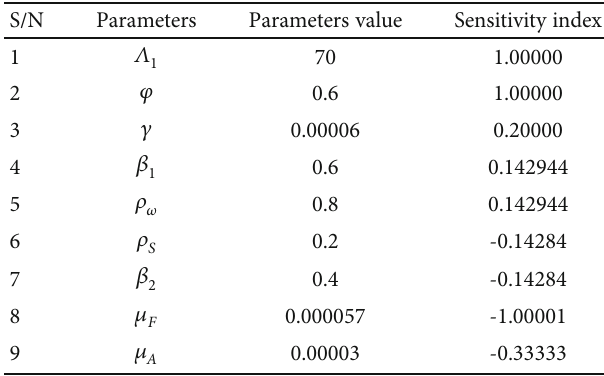
Table 4: Sensitivity index of the parameters.